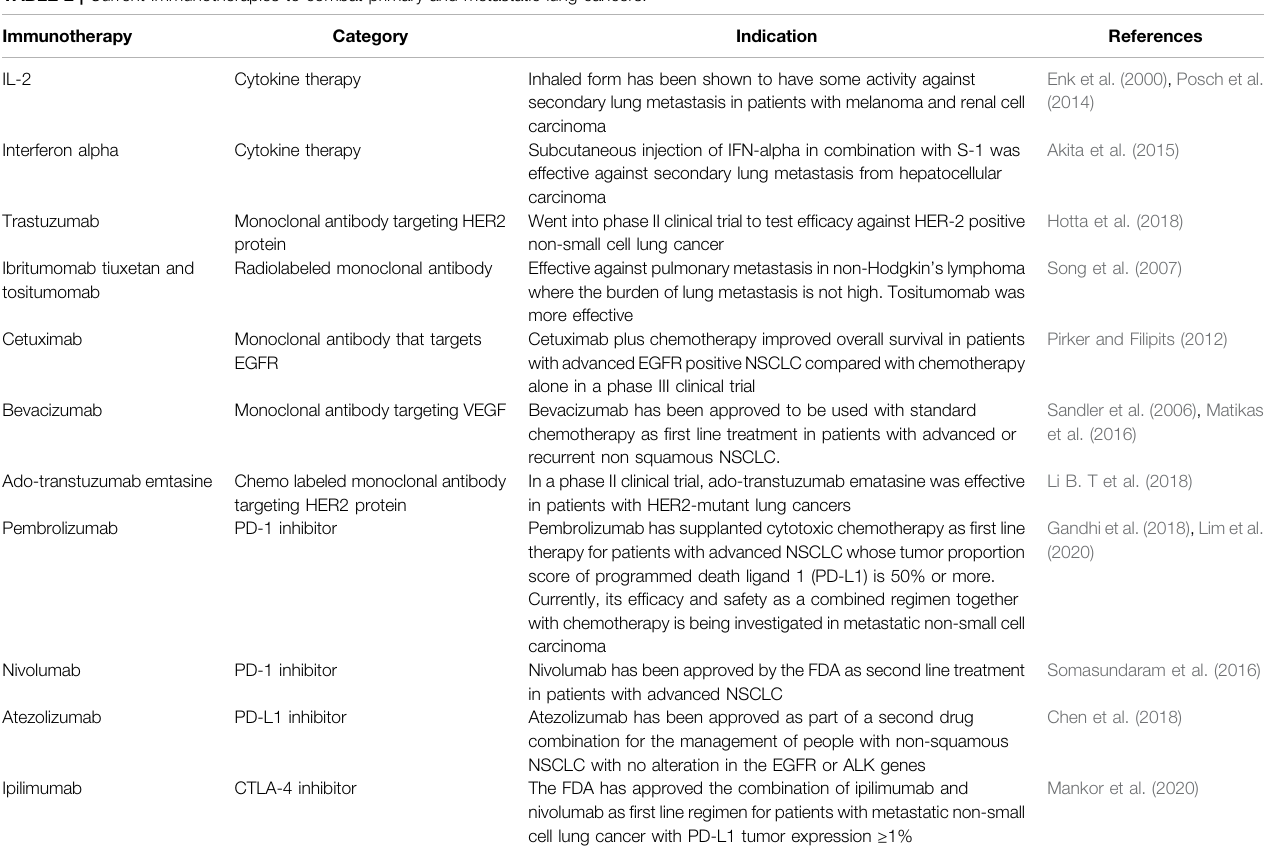
TABLE 2 | Current Immunotherapies to combat primary and metastatic lung